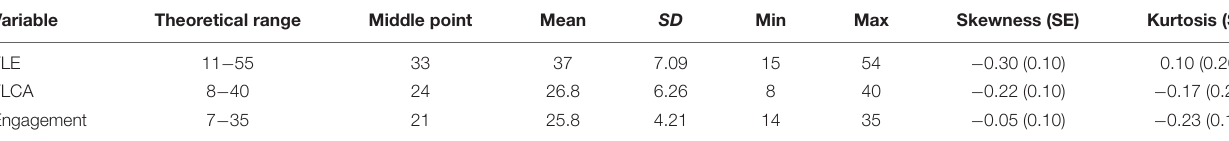
TABLE 1 | Descriptive of the general levels of achievement emotions and behavioral engagement.